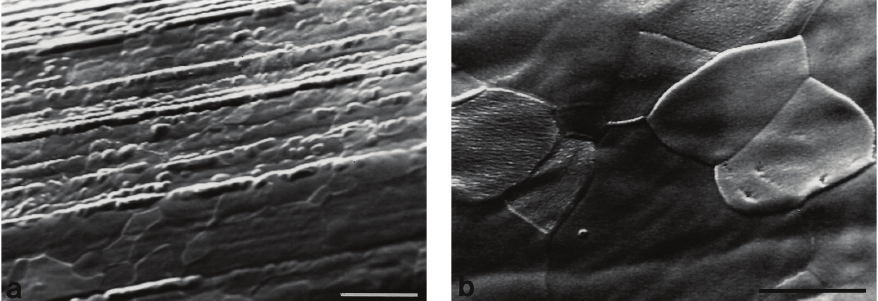
Figure 2: SEM images of the glow-discharge nitrided sample; (a) the machining grooves are smoothened and grain structures are visible. Bar = 10 𝜇 m; (b) the surface topography of the individual grains is relatively smooth. Bar = 5 𝜇